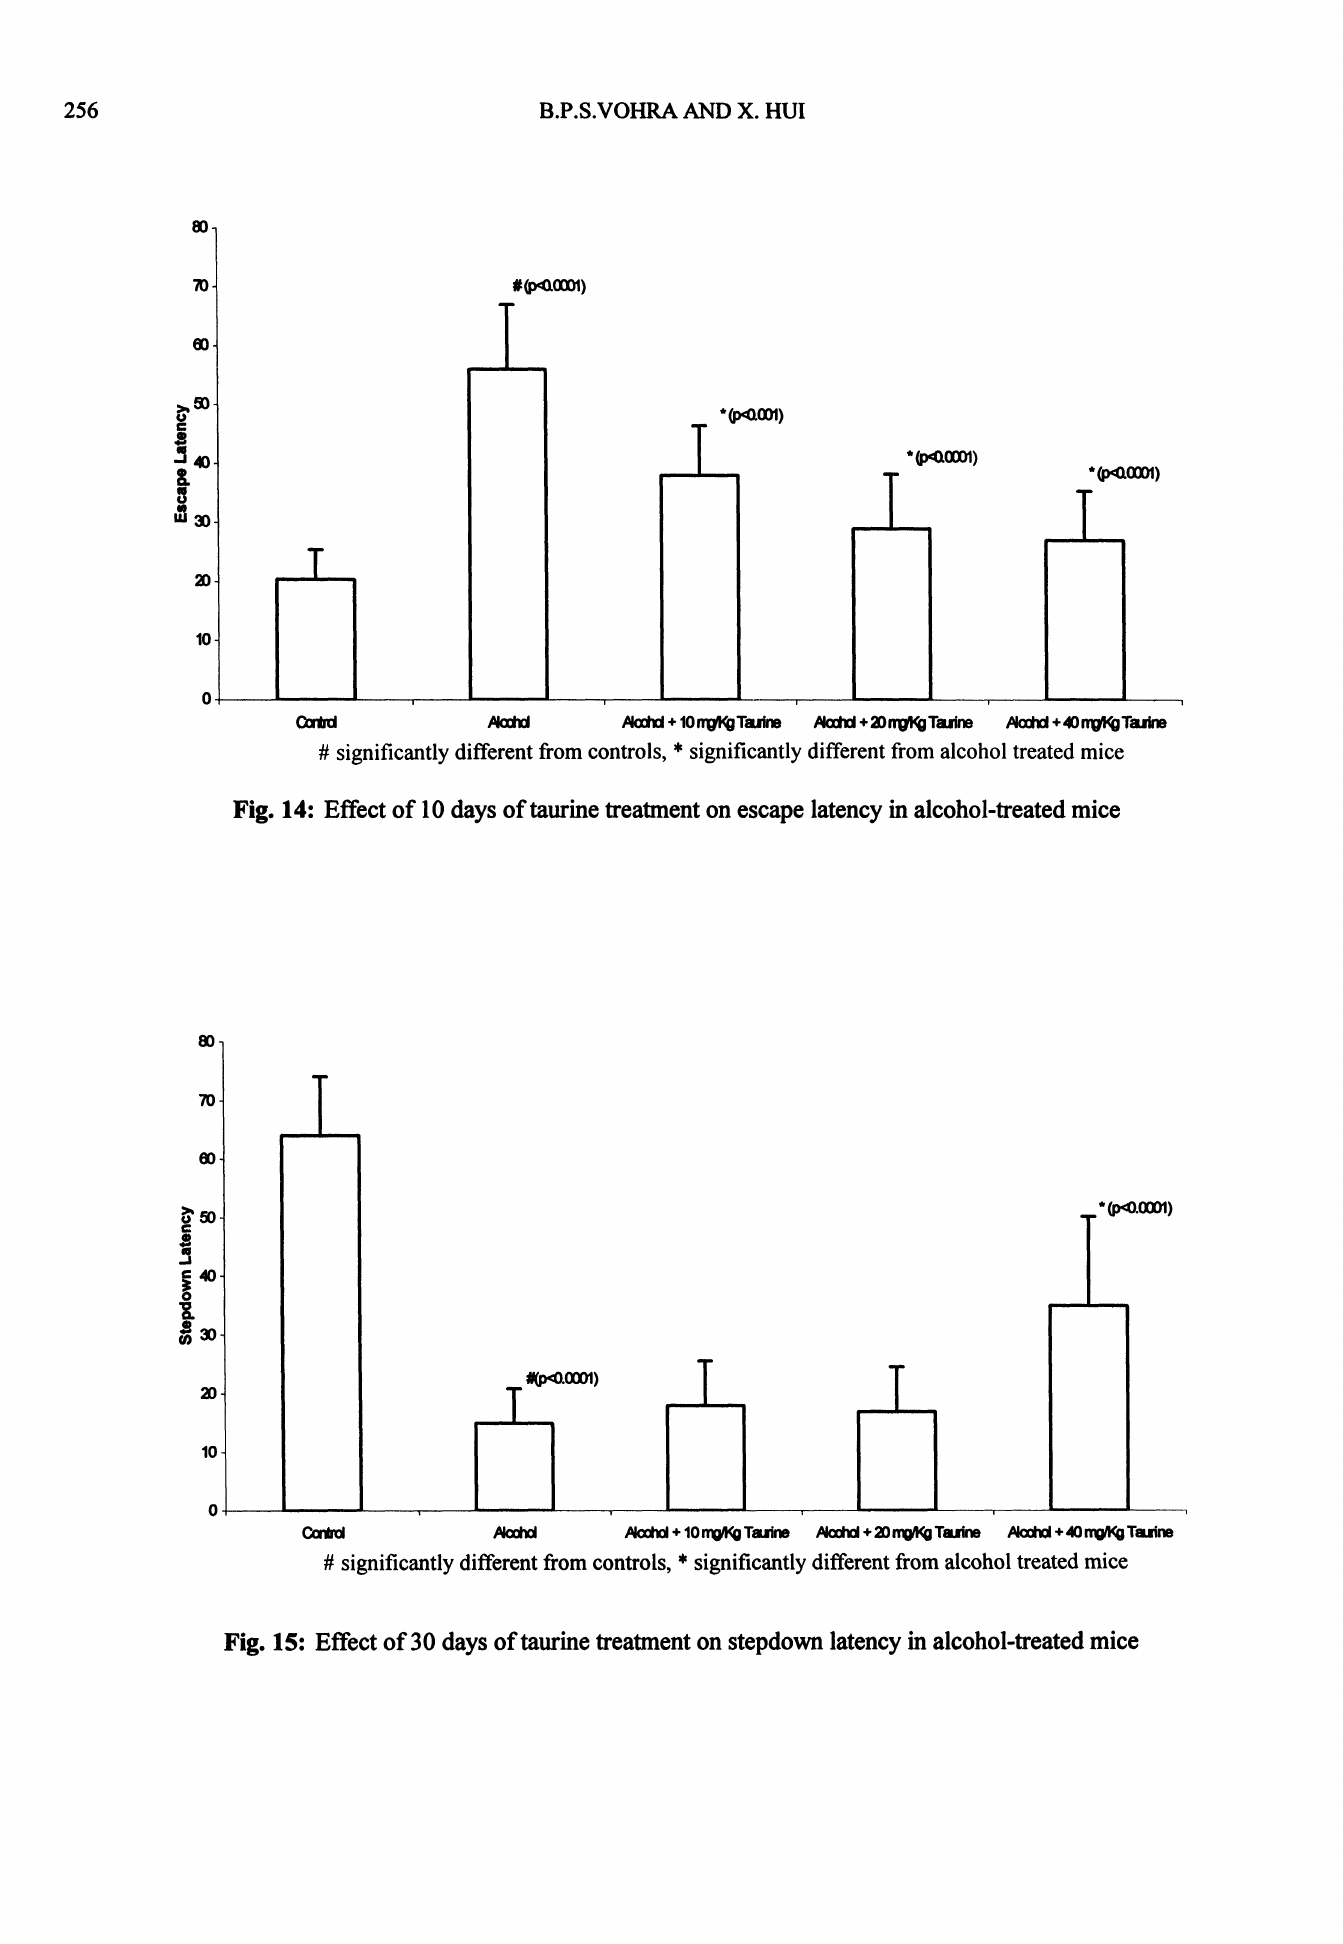
Fig. 15: Effect of 30 days of taurine treatment on stepdown latency in alcohol-treated